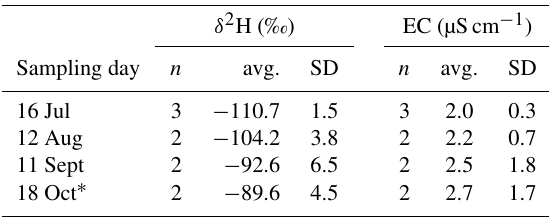
Table 5. Isotopic composition ( δ 2 H) and EC of the glacier melt end- member used in the three-component mixing model for all scenarios for 2013 data. Abbreviations are used as in Table